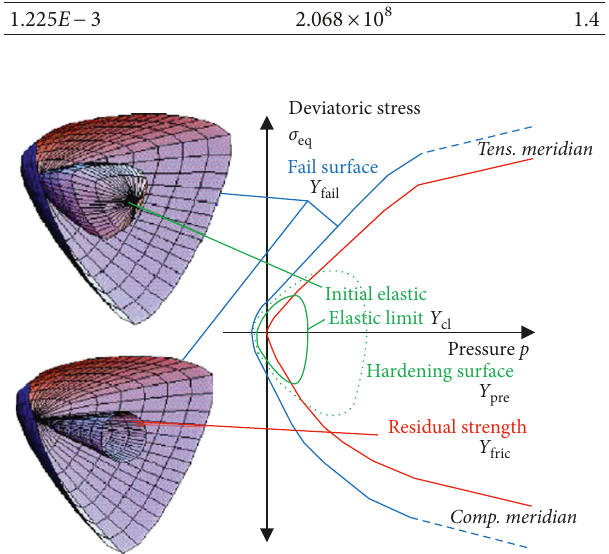
Figure 1: The RHT constitutive model used for